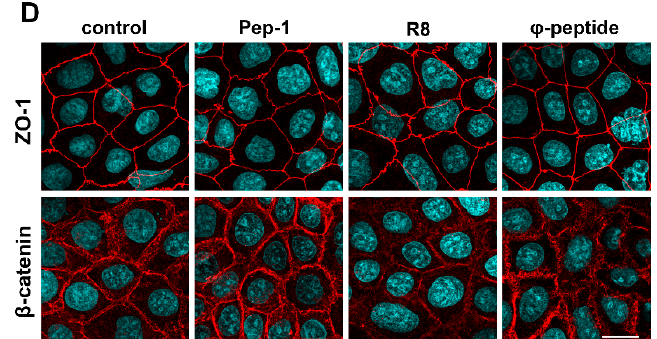
Figure 9. ( A ) Effects of different cell-penetrating peptides (CPPs; 100 μ M, 24 h) on Caco-2 cells followed by impedance measurements. The effects of peptides on the impedance were shown as normalized cell index. Values are presented as means ± SD, n = 3 − 8. ( B ) Evaluation of barrier integrity on Caco-2 cell layers by measurement of transepithelial electrical resistance (TEER) after 1-h CPP treatment. ( C ) Caco-2 cell layer permeability for fluorescein marker molecule (P app A-B 10 − 6 cm/s) after 1-h CPP treatment. ( D ) Effects of CPPs on junctional morphology of Caco-2 cells. Immunostaining for zonula occludens-1 (ZO-1) and β -catenin junctional proteins in control conditions and after 1-h peptide treatment. Red color: immunostaining for ZO-1 and β -catenin. Blue color: staining of cell nuclei. Bar = 20 μ m.